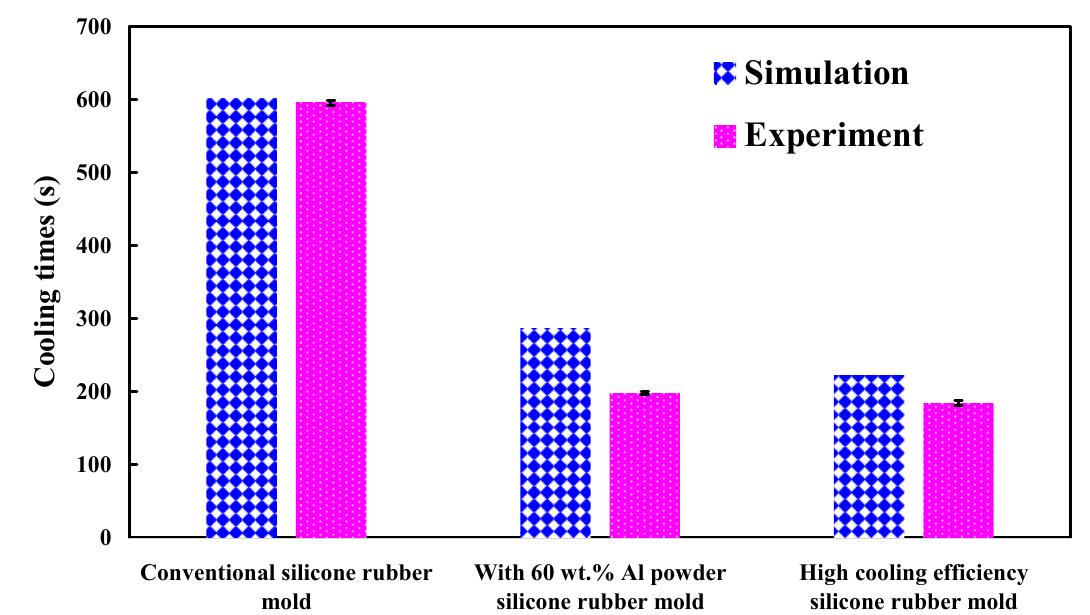
Figure 21. Comparison of the predicted and actual cooling time of injection molded products. Cooling channel flow rate means the volumetric flow rate along the cooling channel.